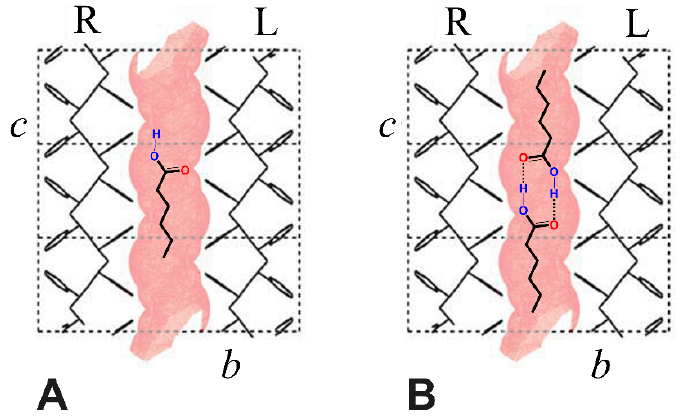
Figure 7. Schematic presentation of isolated ( A ) and dimeric ( B ) HA species in the crystalline channels of the ε form. The parallelism of the aliphatic chain with respect to the chain axis and the minimum energy conformation of the carboxylic groups (C=O eclipsed) are able to rationalize the orientations of O − H and C=O groups, preferentially parallel and perpendicular to the polymer chain crystalline axes, respectively, as established by FTIR linear dichroism measurements.